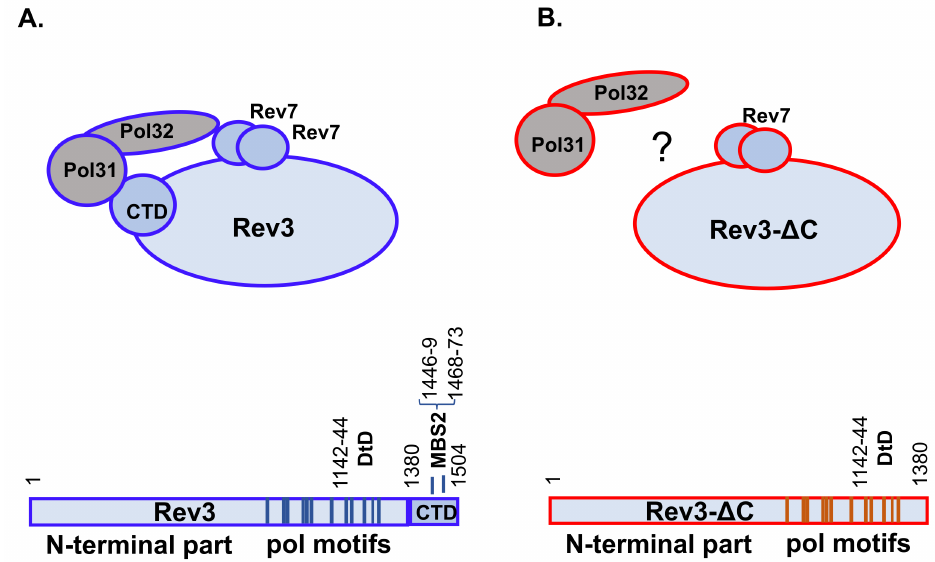
Figure 1. Schematic structures of DNA pol ζ variants under study. ( A ) Classic pol ζ 4 (left image, blue contour) is a hetero-pentamer comprised of Rev3 (catalytic subunit, schematically shown under the structure), a dimer of two small accessory subunits of Rev7, and two subunits shared with DNA pol ∆ , which are bound to the CTD of Rev3, Pol31, and Pol32. Below are the features marked on the amino acid sequence of Rev3: the N-terminal portion of unknown function, the polymerase motifs with the positions of the catalytic residues (DtD), and the C-terminal domain (CTD), along with the metal-binding motif (MBS2) that coordinates the Fe-S cluster. ( B ) Pol ζ Rev3 ∆ C (red contour and outline of the catalytic subunit below) lacking the CTD, the hub thought necessary for interaction with